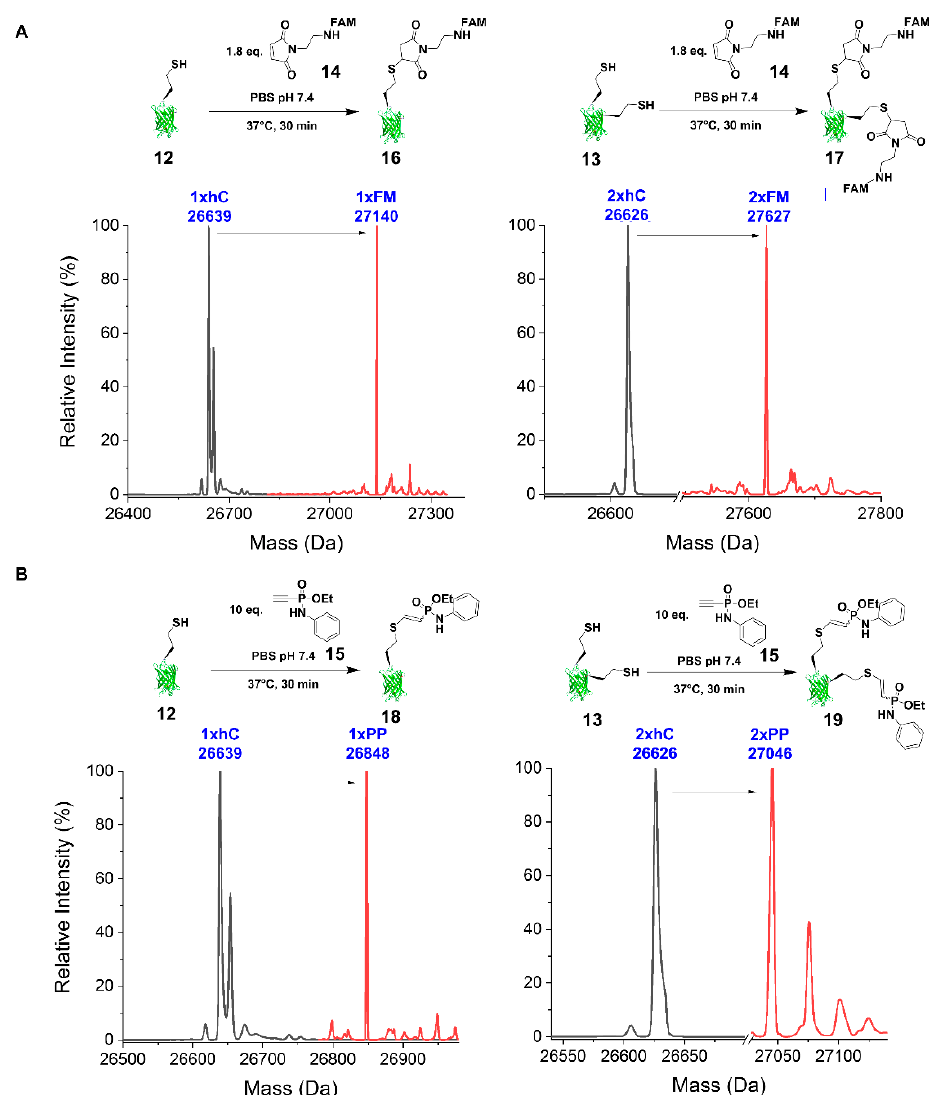
Figure 3. Conjugation reactions of homocysteine-containing deallylated model proteins. ( A ) FAM-maleimide (FM) 14 was conjugated with cfGFPhs1-RM(134HCys) 12 (calculated MW: 26638 Da; detected MW: 26638 Da) and cfGFPhs1-RM(134HCys:143HCys) 13 (calculated MW: 26627 Da; detected MW: 26626 Da) bearing free thiols in PBS pH 7.4 at 37 °C overnight to give cfGFPhs1-RM(134)-S-FM (1xFM) 16 (calculated MW: 27137 Da; detected MW: 27140 Da) [M+3H] + and cfGFPhs1-RM(134:143)-S-FM (2xFM) 17 (calculated MW: 27623 Da; detected MW: 27627 Da) [M+4H] + respectively. ( B ) Phenyl phosphonamidate (PP) 15 was conjugated with cfGFPhs1-RM(134HCys) 12 and cfGFPhs1-RM(134HCys:143HCys) 13 bearing free thiols in PBS pH 7.4 at 37 °C overnight to give cfGFPhs1-RM(134)-S-PP (1xPP) 18 (calculated MW: 26847 Da; detected MW: 26848 Da) [M+H] + and cfGFPhs1-RM(134:143)-S-PP (2xPP) 19 (calculated MW: 27044 Da; detected MW: 27045 Da) [M+H] + respectively.